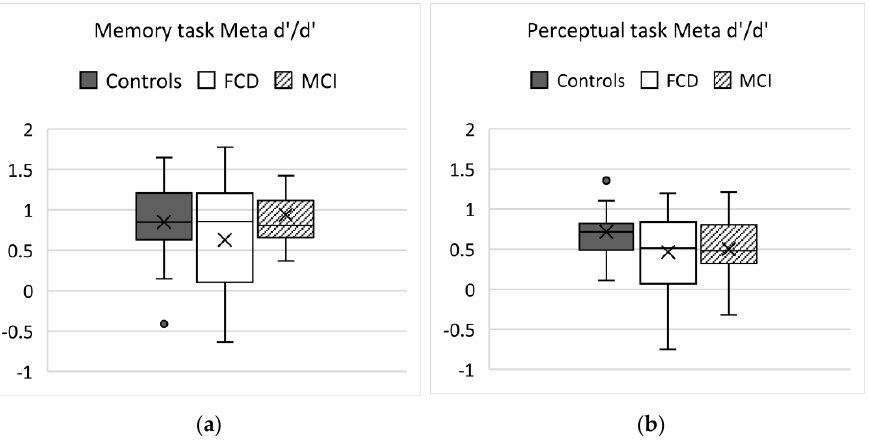
Figure 1. ( a ) Meta-d’/d’ group results on the memory task (all trials). ( b ) Meta-d’/d’ group results on the Perception task.